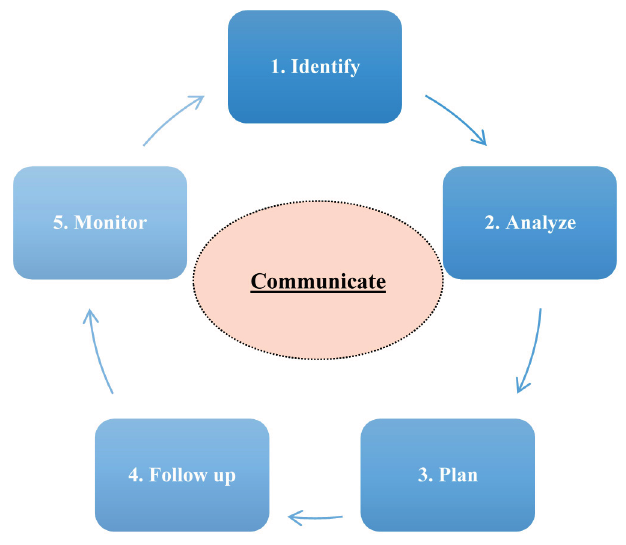
Figure 5. A typical risk management process. Adapted from [18].